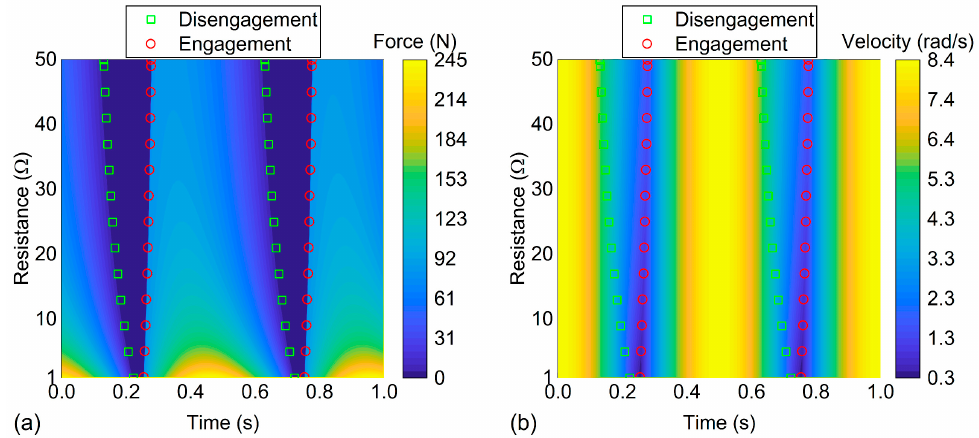
Figure 11. The working characterization of the MMR − EHSA with different resistances (parameters Ω ). ( a ) Total damping force. ( b ) Coupling of input: A = 20 mm, f = 1.0 Hz, R load = 1–50 Ω ). ( a ) Total damping force. ( b ) Coupling velocity. of input: A = 20 mm, f = 1.0 Hz, R load = 1–50